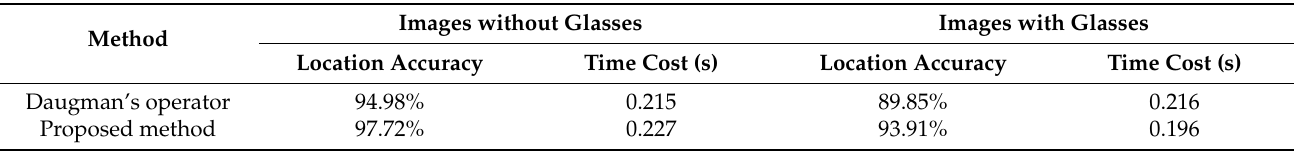
Table 4. Comparison results of iris localization at a long